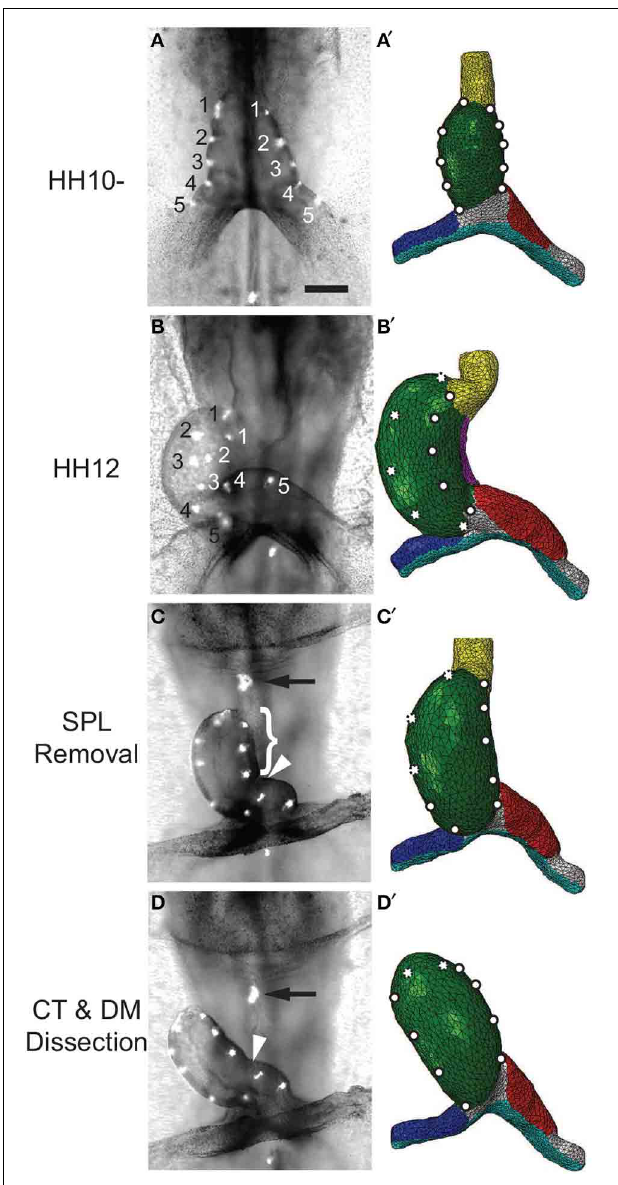
FIGURE 9 | Effects of removing external constraints on heart tube (HT). (A–D) Bright-field images of experimental perturbations reprinted from Voronov et al. (2004) with permission of Elsevier. (A (cid:2) –D (cid:2) ) Corresponding finite-element simulations. (A,A (cid:2) ) Straight HT at HH10-. To help visualize rotation, fluorescent labels were injected along the lateral sides of the HT in the experiment, and artificial labels are placed at similar locations in the model. (B,B (cid:2) ) Same heart at HH12 after 6h of culture. As the heart rotates rightward, labels on the right (black numbers) and left (white numbers) sides of the HT move toward the dorsal and ventral sides, respectively. The model captures this phenomenon, as the labels originally on the right side now become invisible (dotted circles). (C,C (cid:2) ) Same heart at HH12 after removal of the splanchnopleure (SPL). In both the experiment and model, most rotation disappears as heart untwists, but heart remains bent slightly toward the right. (D,D (cid:2) ) Heart in (C) after transverse dissection of conotruncus (CT, black arrow) and longitudinal dissection of DM [brace in (C) shows length of the cut]. In both experiment and model, the HT tilts toward the right. In addition, the interventricular groove (white arrowhead) smooths out as the heart unbends. Scale bar: 200 μ